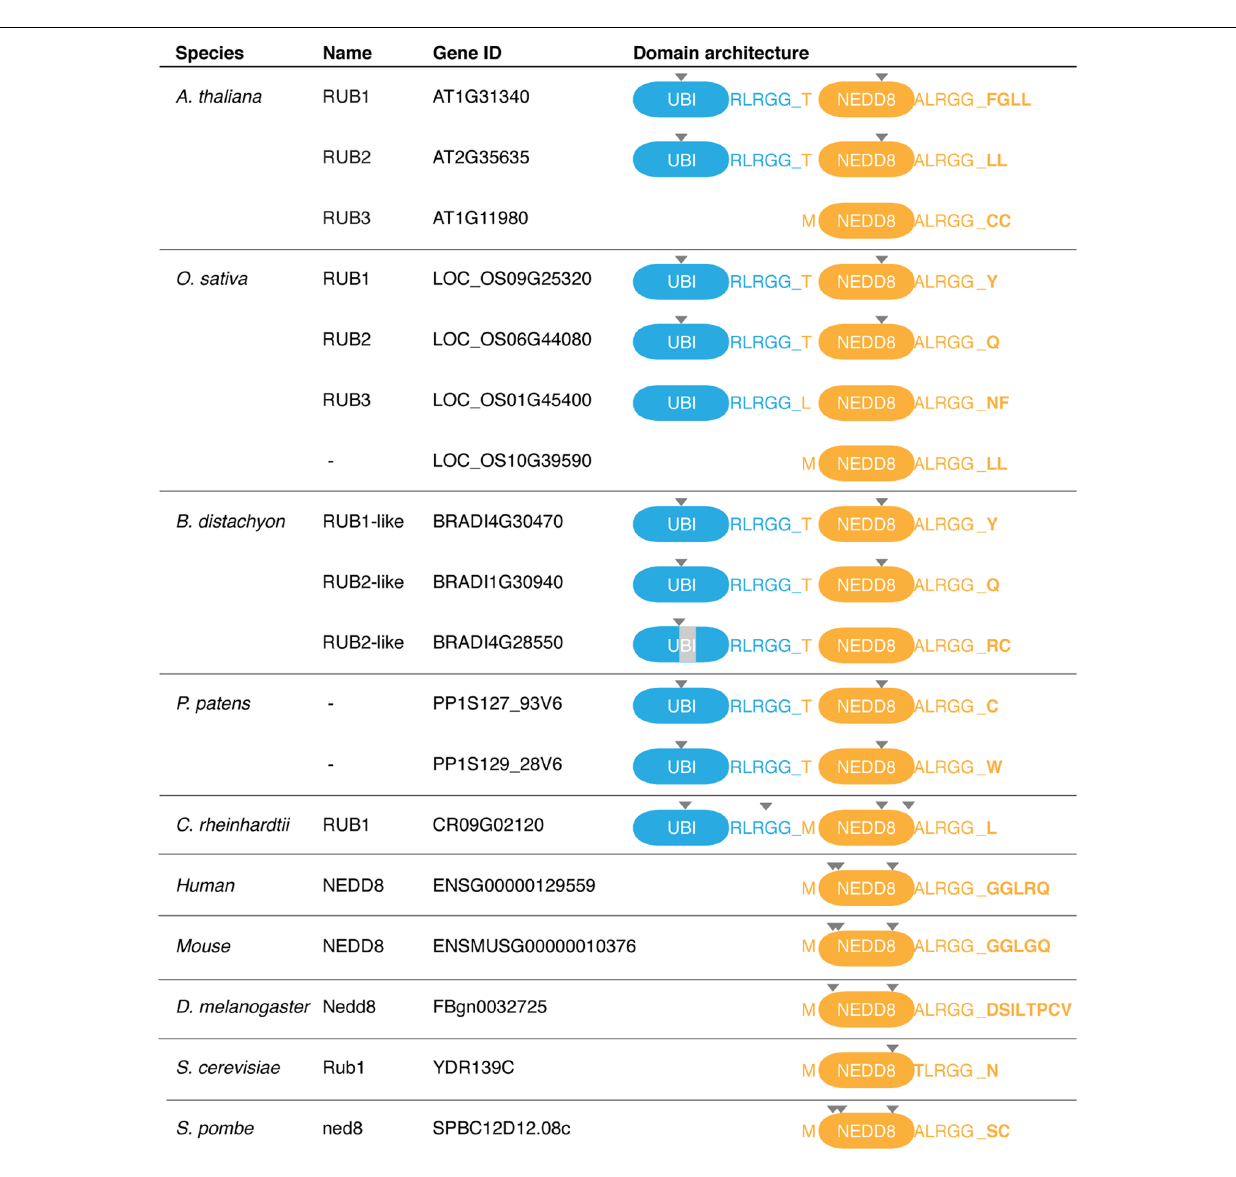
FIGURE 1 | Protein domain organization of NEDD8 proteins from several representative species. Gene identification numbers (Gene IDs) are as listed in www.ensemblgenomes.org. Specifically indicated are the last five amino acids of the respective proteins before the proteolytic cleave sites, the first amino acid of NEDD8 and the proteins’ C-terminal amino acids. Proteolytic processing occurs after the C-terminal RGG residues and is indicated by an underscore. Positions of introns in the respective genes are indicated by a